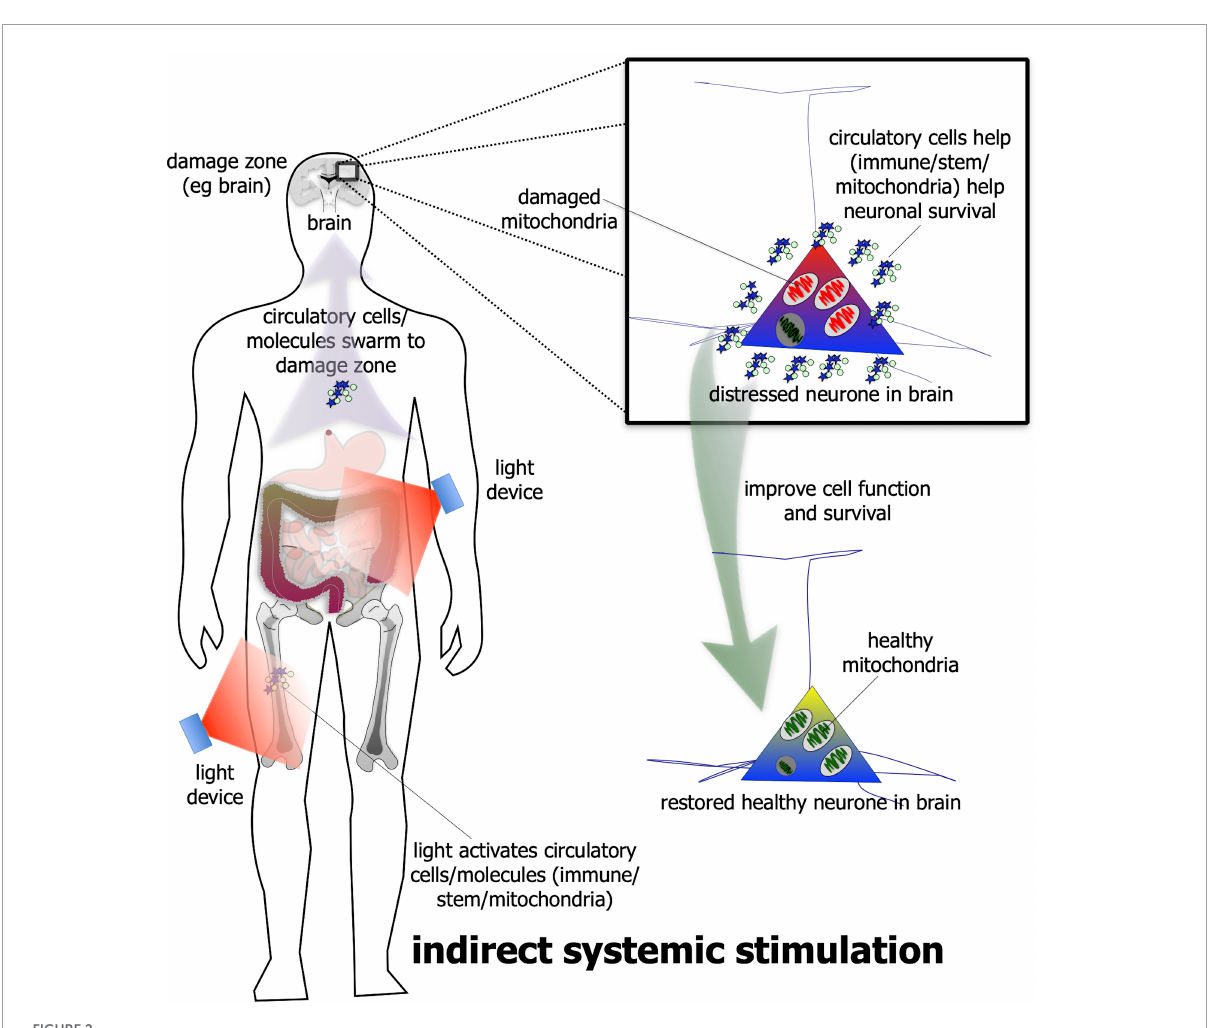
FIGURE2 Schematic diagram showing the indirect stimulation mechanism of photobiomodulation. When photobiomodulation is applied to an organ/structure (e.g., thigh or abdomen) distant from the damage zone (e.g., brain), it may activate circulatory cells, for example stem or immune cells or even the free-floating mitochondria in the plasma, that swarm to the site of damage and improve cell function and/or survival. The net result is a healthier cell. Although this method can be effective in neuroprotection in a range of animal models of disease, it is not quite as effective as the direct photobiomodulation